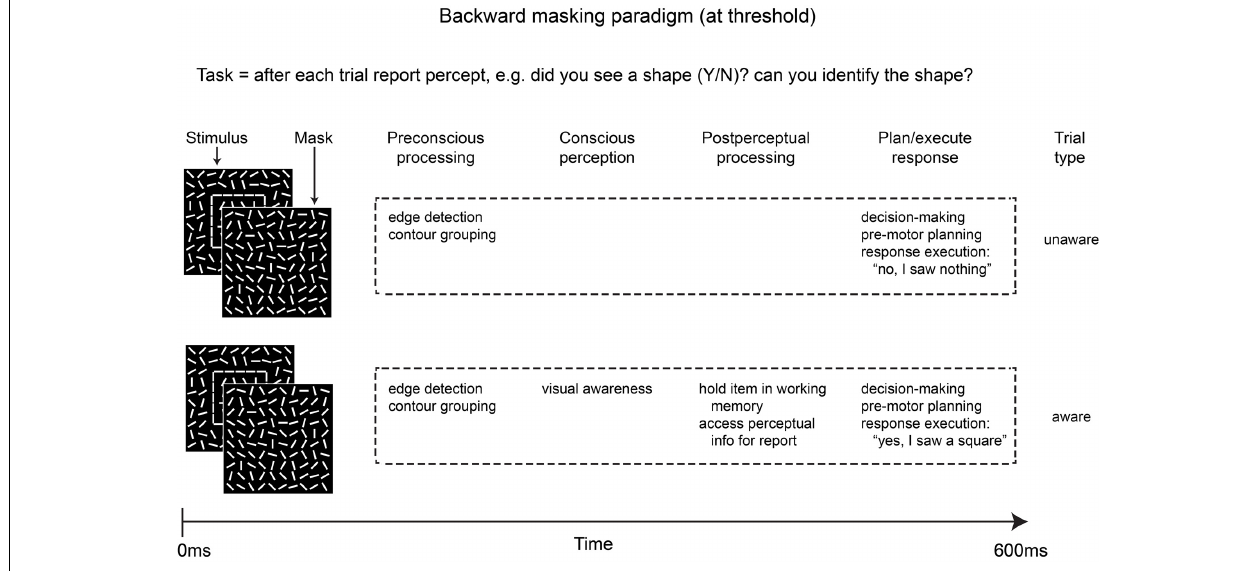
(e.g., 50ms) and is visible on roughly 50% of trials. In addition to differences in conscious perception, post-perceptual processing is likely to differ across the two trial types due to the task